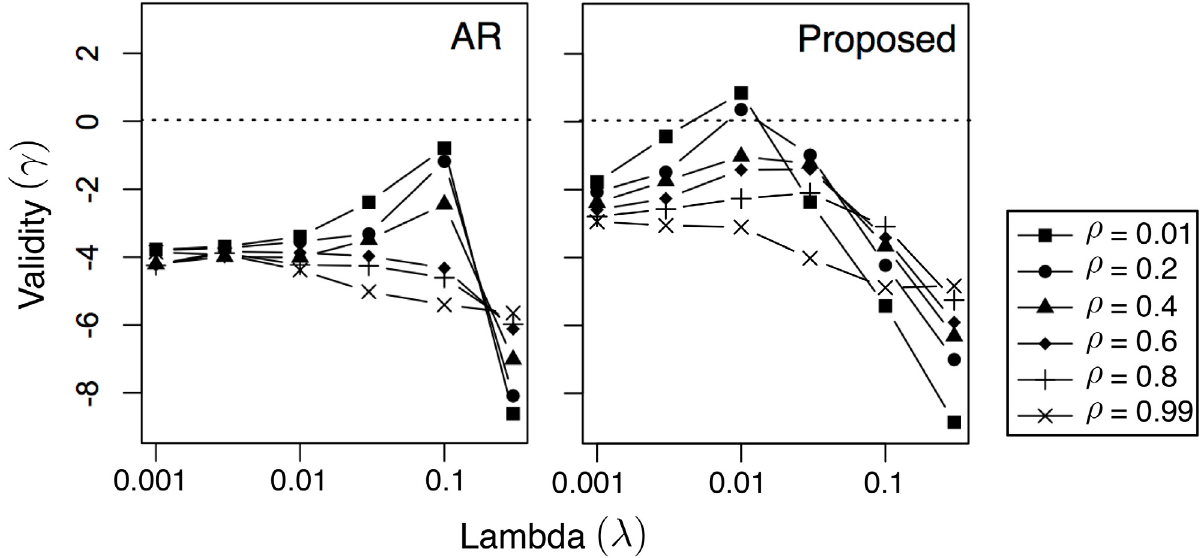
Fig 6. Influence of λ on solution validity γ using different values of ρ . The dotted lines mark λ (cid:9) 0, above which the solution is considered